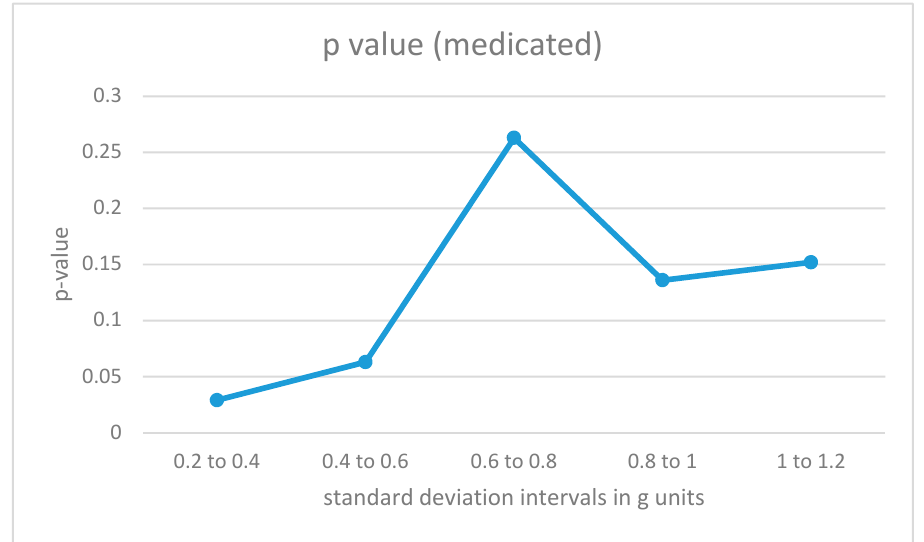
Figure 6. p-Values for acceleration intervals with different movement intensities for non-medicated participants with ADHD.